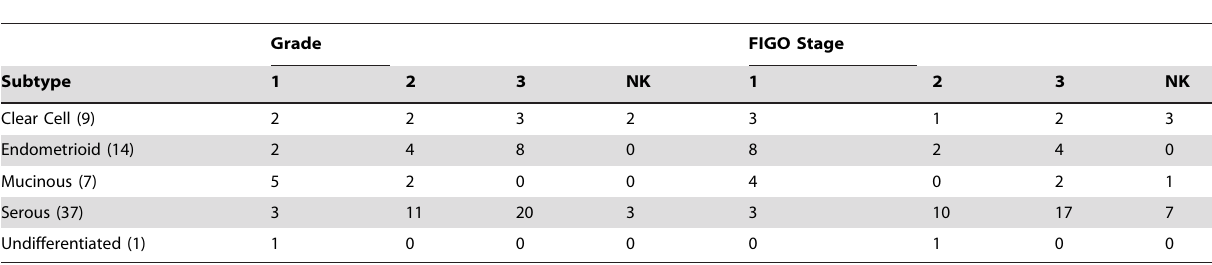
Table 1. Summary of samples analysed by SNP and expression array.